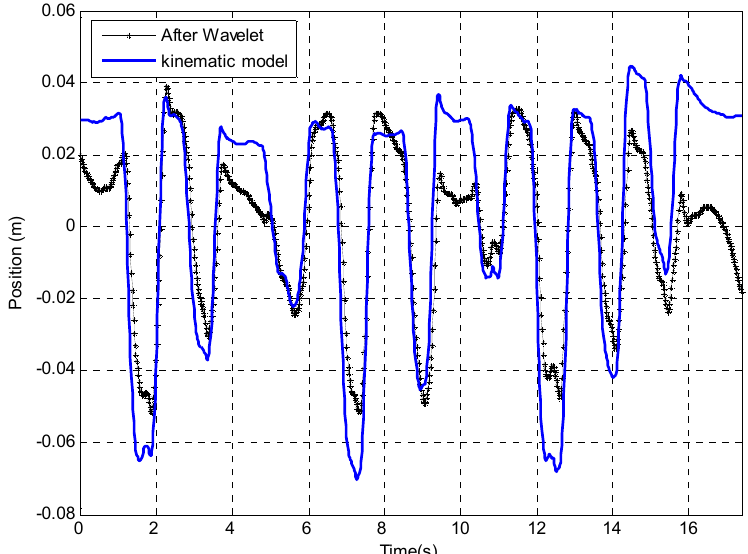
Figure 14. Drift removed by wavelet compared with the kinematic model.